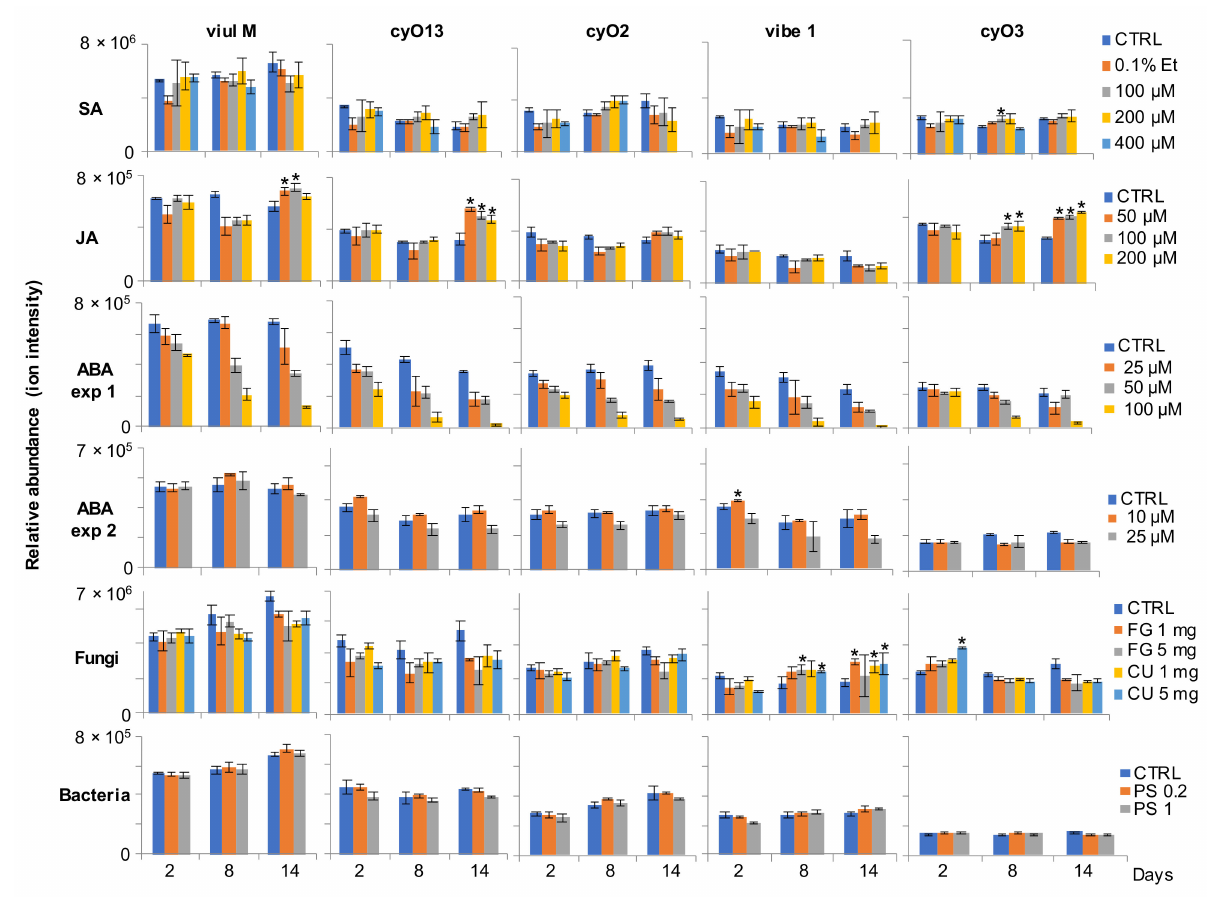
Figure 4. The influence of plant stress hormones (JA, SA, ABA) and biotic elicitors (neutralized fungi and bacteria) on the relative quantity of the five most abundant cyclotides (viul M, cyO13, cyO2, vibe 1, cyO3) produced by the V. uliginosa cell suspension cultures at different timepoints from treatment. Significant increases in cyclotide production in comparison to controls (ANOVA with t -test, p < 0.05) are marked with an asterisk. Each treatment and controls were in triplicates (n =